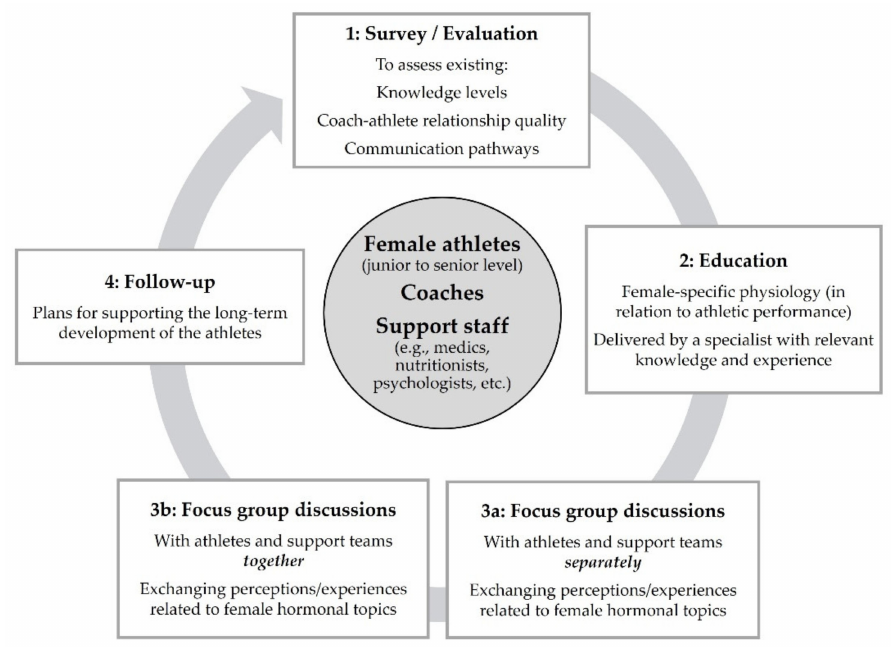
Figure 2. A working model for overcoming barriers to communicating about the female hormonal